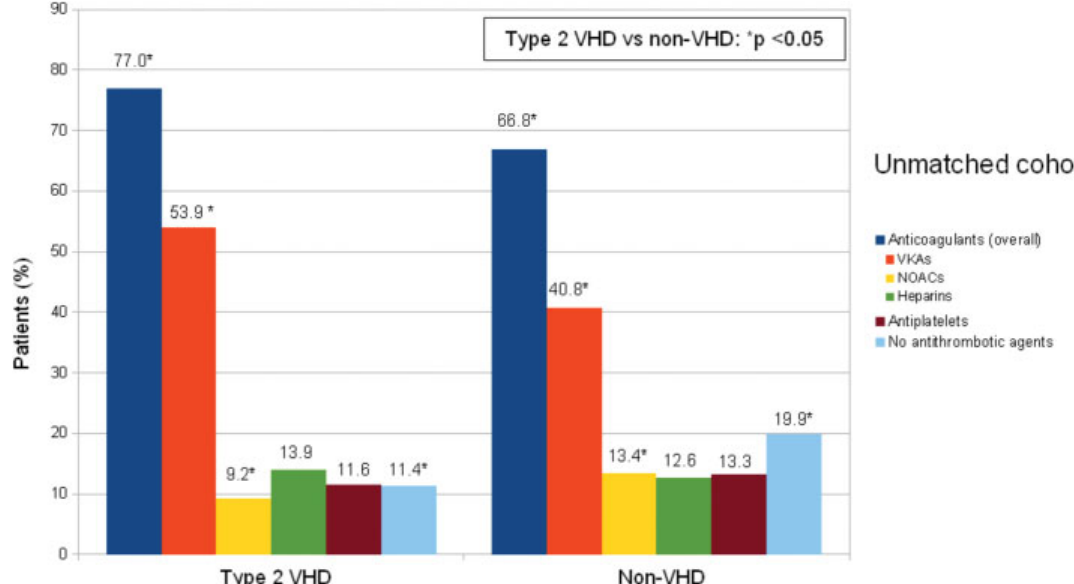
Fig. 2 Treatment distribution in type 2 VHD and in non-VHD unmatched patients at entry visit. VHD, valvular heart disease